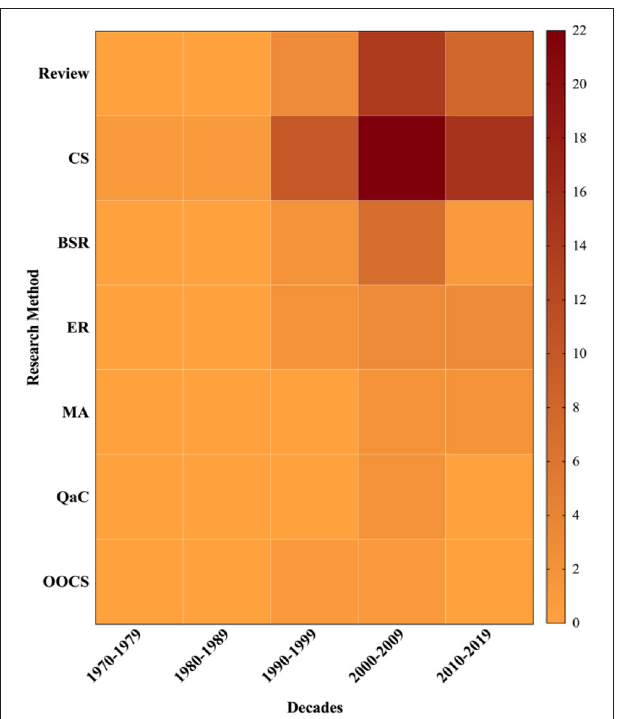
FIGURE 7 | Article categories vs.